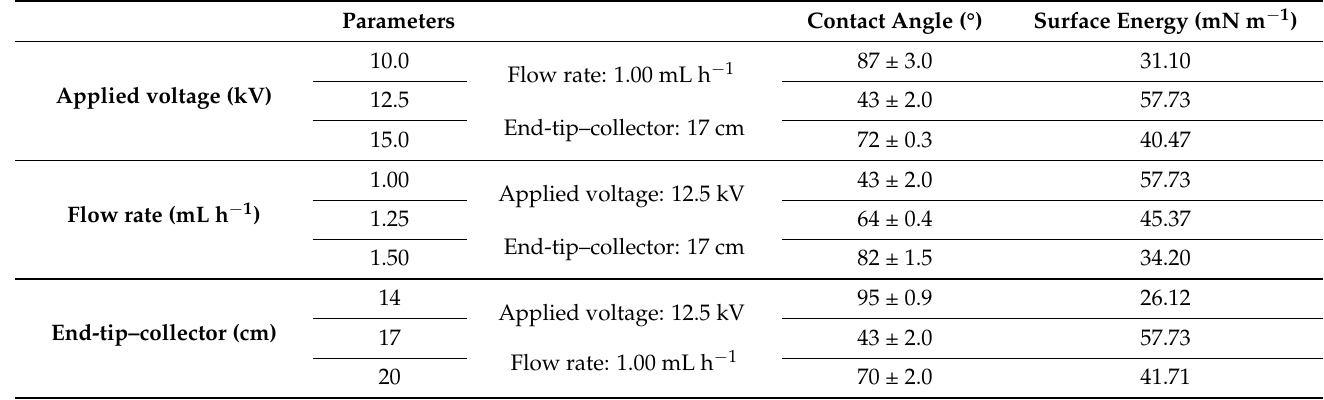
Table 5. The effect of system parameters applied for the fabrication of TPU fibers containing 20 wt % SJWO on the contact angle and surface energy of the